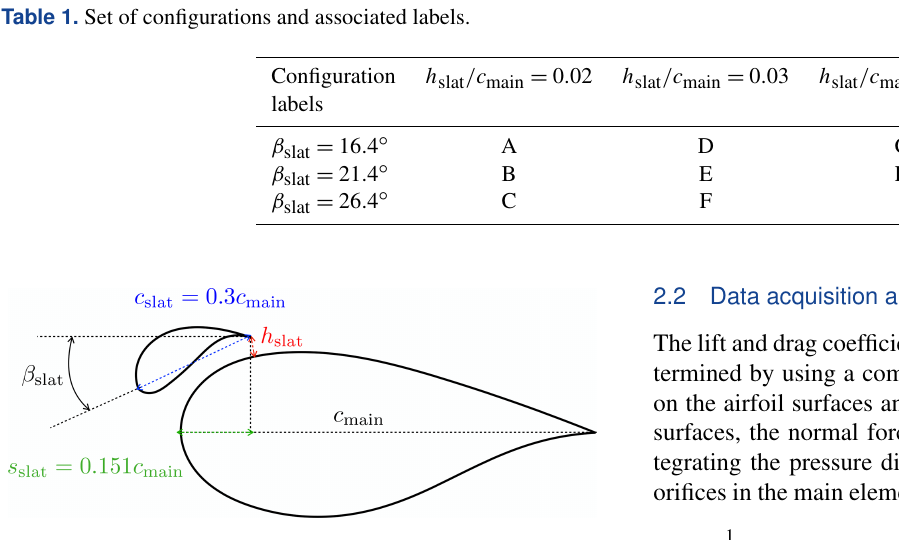
Figure 1. Illustration of the slat parameters of interest in this work: (i) gap width h slat between the main airfoil and the slat and (ii) the slat angle β slat relative to the main